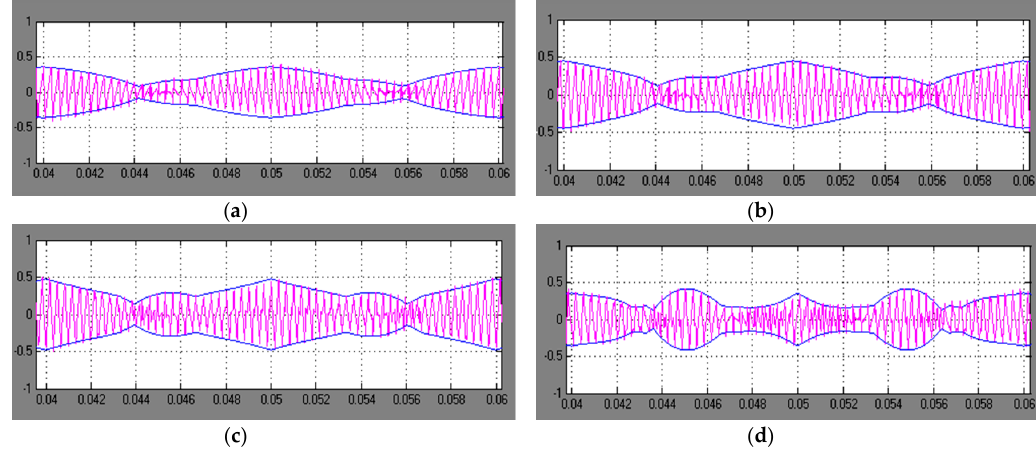
Figure 25. Experimental current ripple and theoretical envelope in the case of DPWM+ for: ( a ) m = 1/6; ( b ) m = 1/4; ( c ) m = 1/3; and ( d ) m = 1/2.